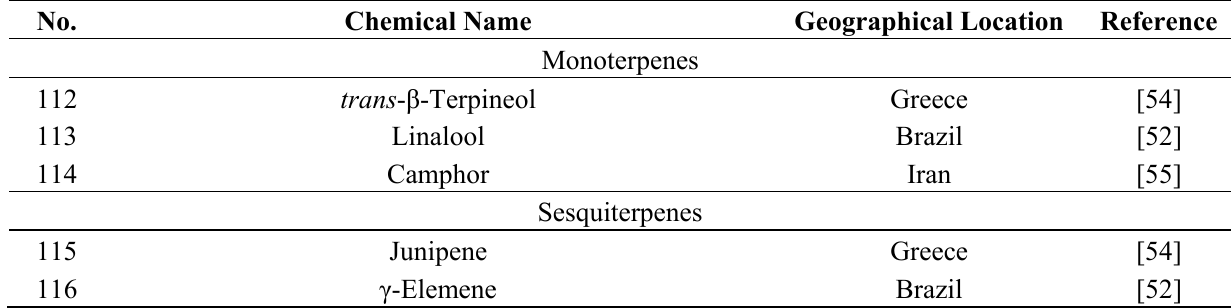
Table 2. Terpenes identified in propolis since